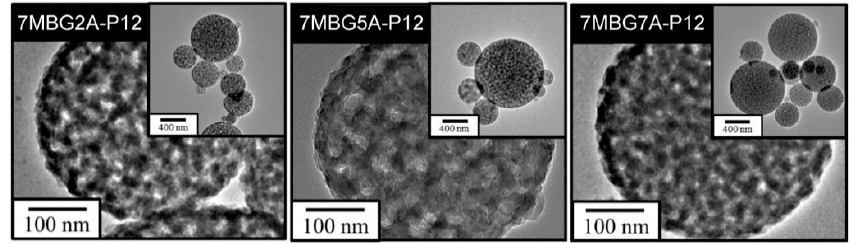
Figure 6. The FE-TEM images of MBG adding different concentrations of CH 3 COOH.